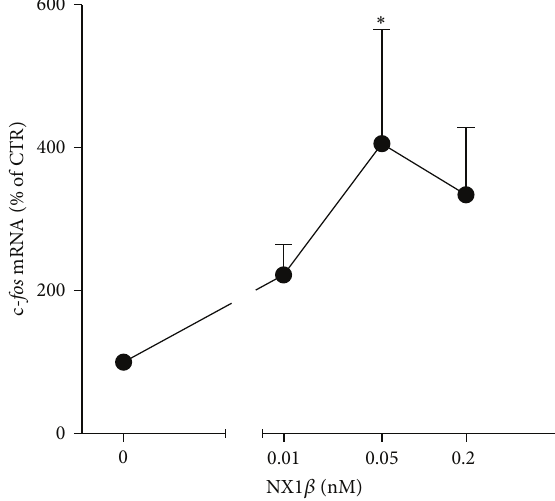
Figure 3: NX1 𝛽 activates Rac1. Cortical neurons were grown for 8 days and subsequently treated with different concentrations of recombinant NX1 𝛽 for 20 min, and the level of active Rac1 (Rac1- GTP) was analyzed using immunoblotting. The results from 𝑛 = 4 experiments are expressed as a percentage ± SEM. ∗ 𝑃 < 0.05 , compared with the untreated control set at 100%.